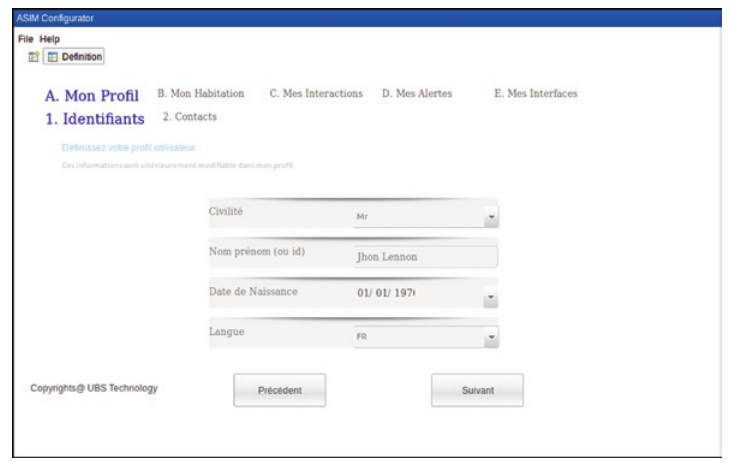
Figure 5: ASIM Generator Interface Using a Questionnaire Form on a